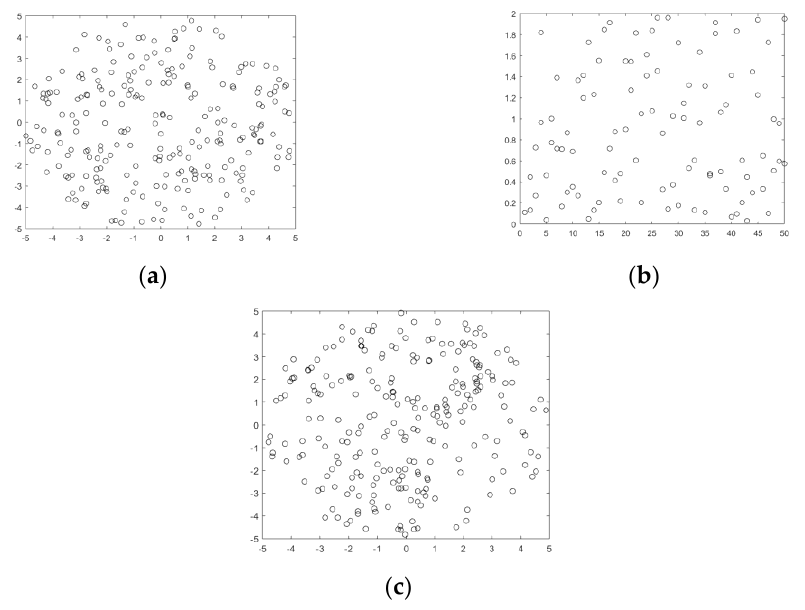
Figure 3. Point process types: ( a ) Poisson; ( b ) inhibition Poisson; and ( c ) determinantal.